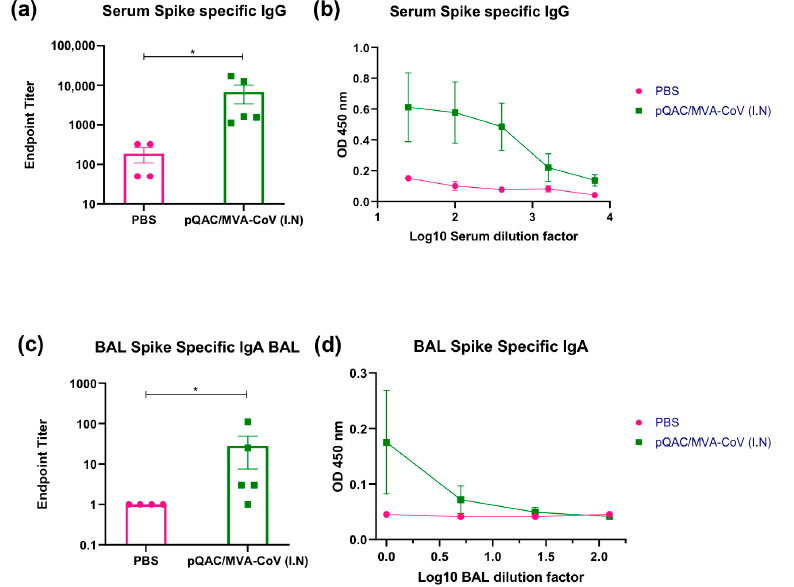
Figure 3. Heterologous vaccine strategy elicits spike-binding antibody responses. Groups of C57BL/5 mice were either unvaccinated (PBS) or immunized with pQAC/MVA-CoV (I.N). Serum and BAL samples were collected 3 weeks post boost. ( a ) SARS-CoV-2 spike-specific serum IgG binding endpoint titers measured by ELISA. ( b ) Serial serum dilutions of IgG binding to SARS-CoV-2 spike protein. ( c ) SARS-CoV-2 spike-specific BAL IgA binding endpoint titers measured by ELISA. ( d ) Serial BAL dilutions of IgA binding to SARS-CoV-2 spike protein. Significance (*, p < 0.05) was determined by one-way ANOVA. Data show mean ± SEM.